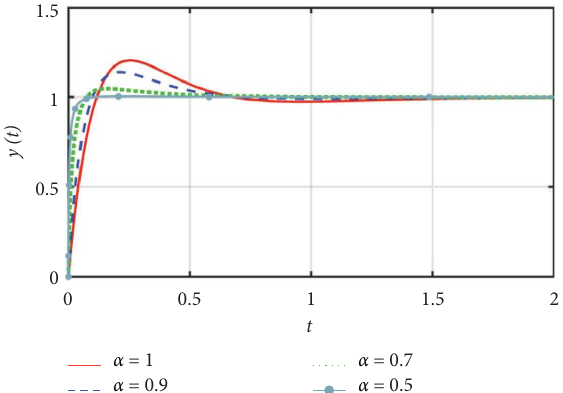
corresponding to step signal 1